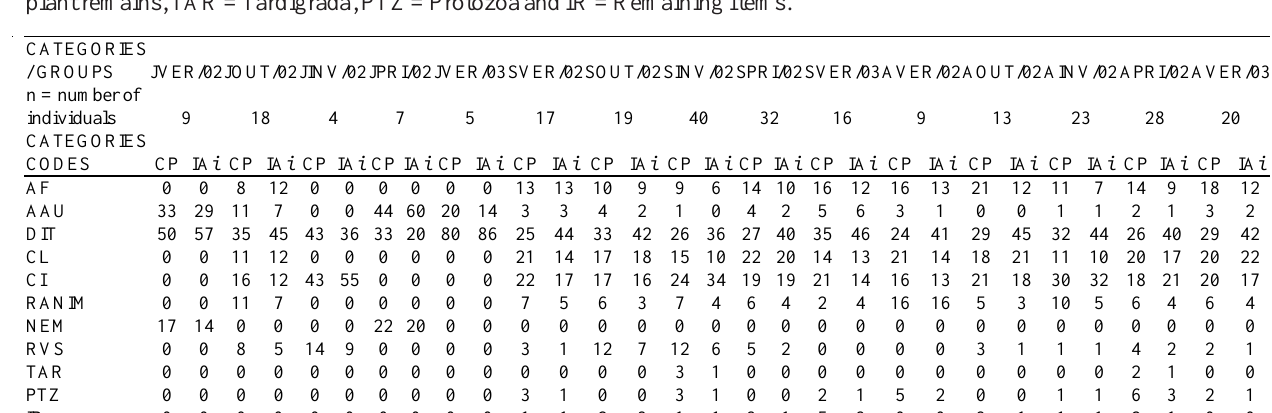
Table 6. Contribution of microscopic diet categories of D. langei represented by Percentage Composition (CP) and Feeding Index (IA ), comparing the total length (Lt) categories Juveniles (J = Lt < 3 cm), Semi-adults (S = 3 < Lt < 8 cm) and Adults (A i = Lt > 8 cm) and seasons: VER = Summer (December, January and February), OUT = Autumn (March, April and May), INV = Winter (June, July and August) and Spring = PRI (September, October and November). Group codes are: JVER/02= Juveniles Summer / 2002, JO2 = Juveniles Autumn / 2002, JI2 = Juveniles Winter / 2002, JP2 = Juveniles Spring / 2002, JV3 = Juveniles Summer / 2003, SV2 = Semi-adults Summer / 2002, SO2 = Semi-adults Autumn / 2002, SI2 = Semi-adults Winter / 2002, SP2 = Semi-adults Spring / 2002, SV3 = Semi-adults Summer / 2003, AV2 = Adults Summer / 2002, AO2 = Adults Autumn / 2002, AI2 = Adults Winter / 2002, AP2 = Adults Spring / 2002 and AV3 = Adults Summer / 2003. Microscopic diet codes are: AF = Microscopic Filamentous Algae, AAU = Microscropic Autochthonous Arthropods, DIT = Unicellular Diatoms, CL = Unicel- lular Chlorophytes, CI = Unicellular Cyanophytes, RANI = Non Identifiable Arthropod Parts, NEM = Nematodes, RVS = higher plant remains, TAR = Tardigrada, PTZ = Protozoa and IR = Remaining Items.